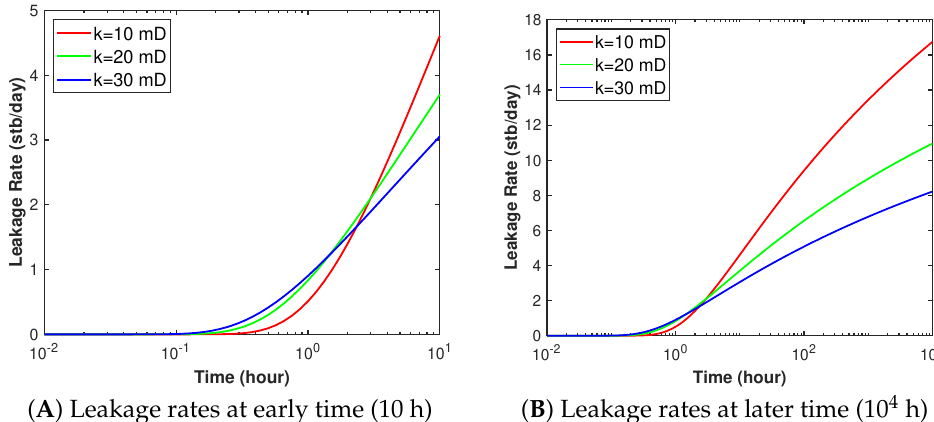
Figure 8. Leakage rate profiles for three scenarios where the permeability in the lower layer corre- sponds to k = 10, 20, and 30 mD.